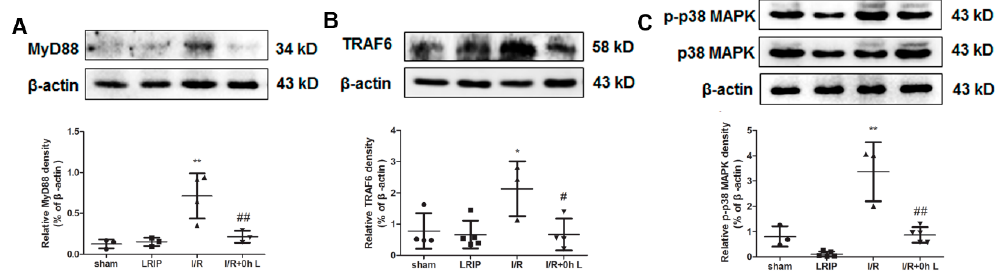
Figure 6. The Myeloid differentiation factor 88 (MyD88)/Tumor necrosis factor (TNF) receptor-associated factor 6 (TRAF6)/p38 mitogen-activated protein kinase (p38-MAPK) signaling pathway is involved in the mechanism through with LRIP protects against I/R injury. Representative images of Western blot assessments and the quantitative analysis of the ratio of: MyD88 ( A ); TRAF6 ( B ); and p-p38 MAPK ( C ). Data are expressed as mean ± SD, n = 3, * p < 0.05 vs. sham group, ** p < 0.01 vs. sham group, # p < 0.05 vs. I/R group, ## p < 0.01 vs. I/R group.